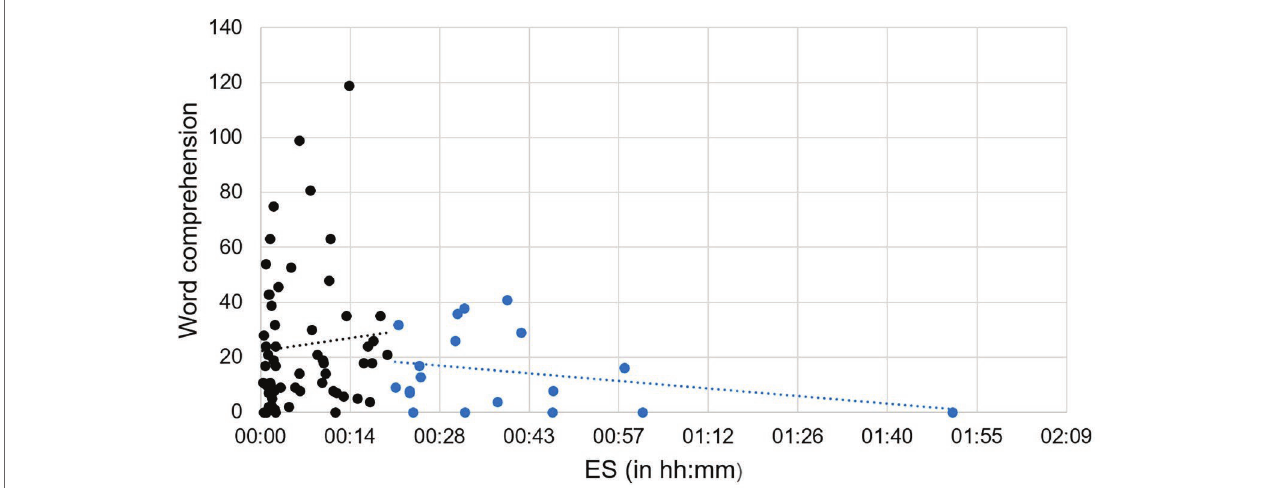
FIGURE 2 | Scatterplot ( n = 78) of the non-significant negative association between ES and Word comprehension. Black dots indicate participants with ES less than 20 minutes and blue dots indicate participants with ES greater than 20